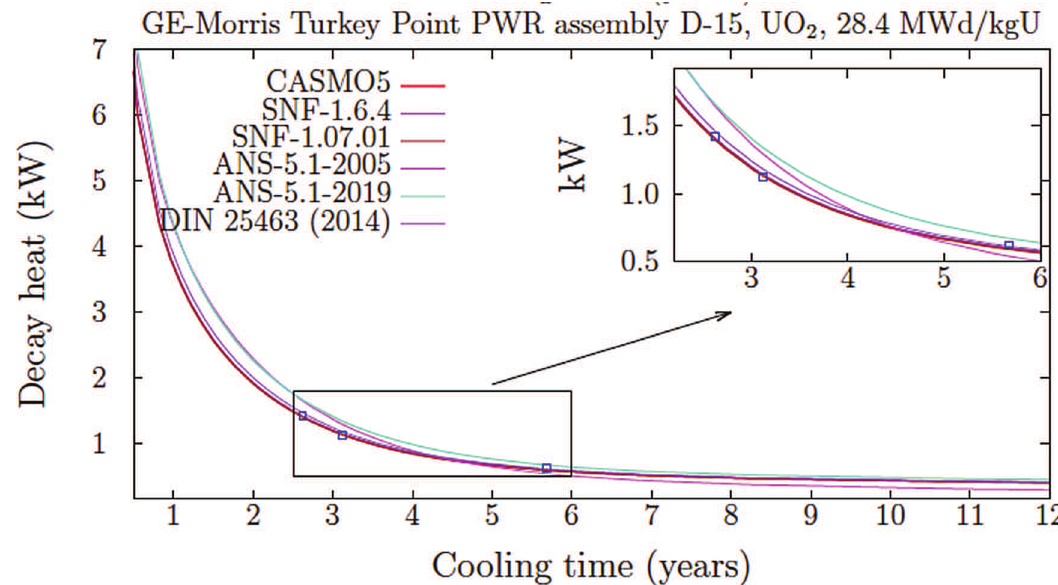
Fig. 1. Comparison of the measured and calculated decay heat for a specific PWR assembly from the GE-Morris facility. work performed in this subtask is expected for the end of